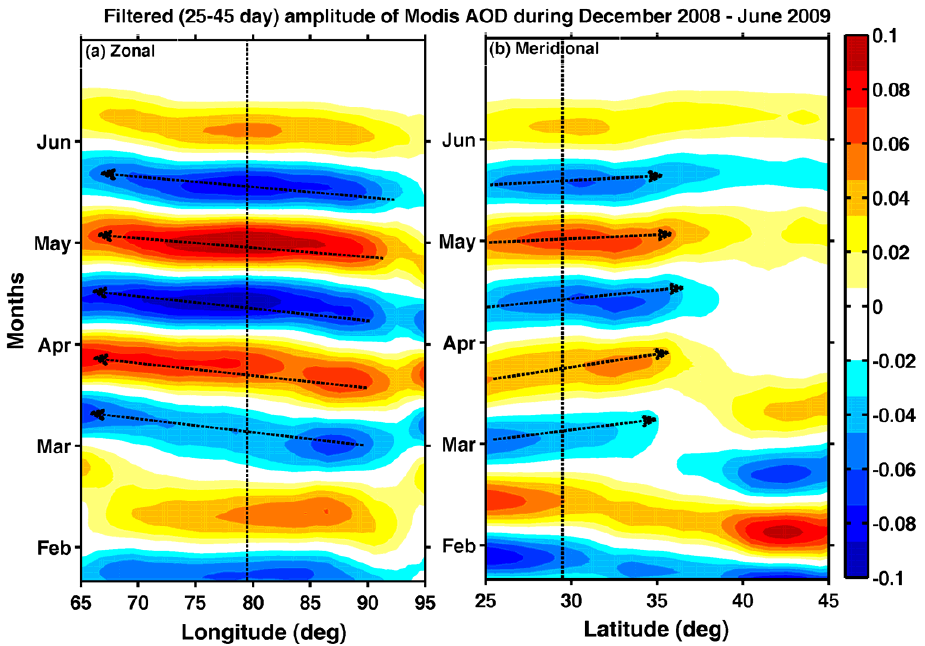
Fig. 4. Time–longitude section of filtered (25–45 day) amplitudes of MODIS AOD from December 2008 to June 2009 for (a) zonal prop- agation (longitude) and (b) meridional propagation (latitude). Dotted line represents the longitude and latitude of the observational site and arrows indicate the direction (westward/northward) of